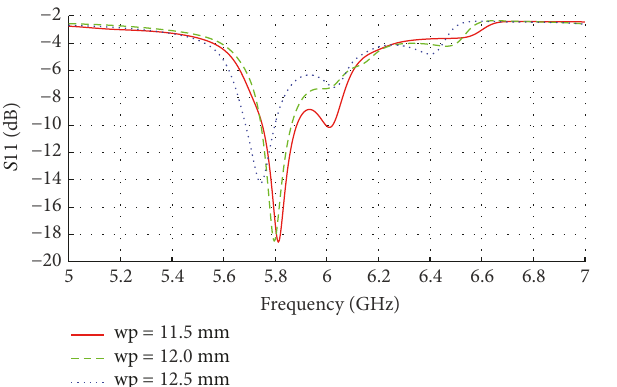
Figure 8: The optimization of width of the radiation patch.